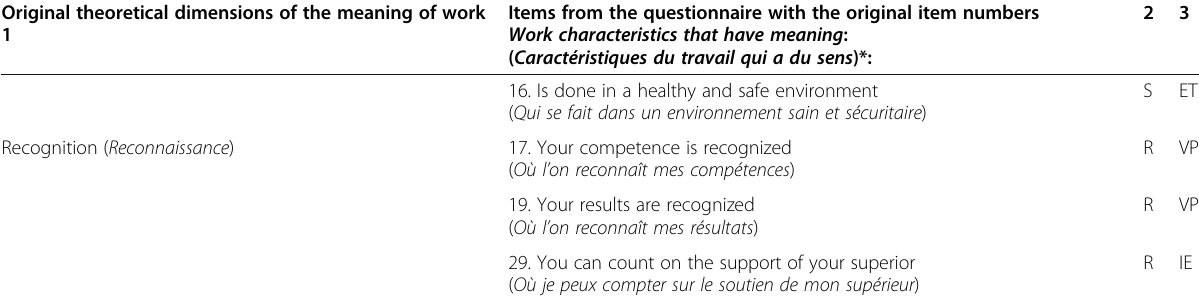
Table 3 Items from the meaning of work scale by Morin with their theoretical dimensions and exploratory factor analyses